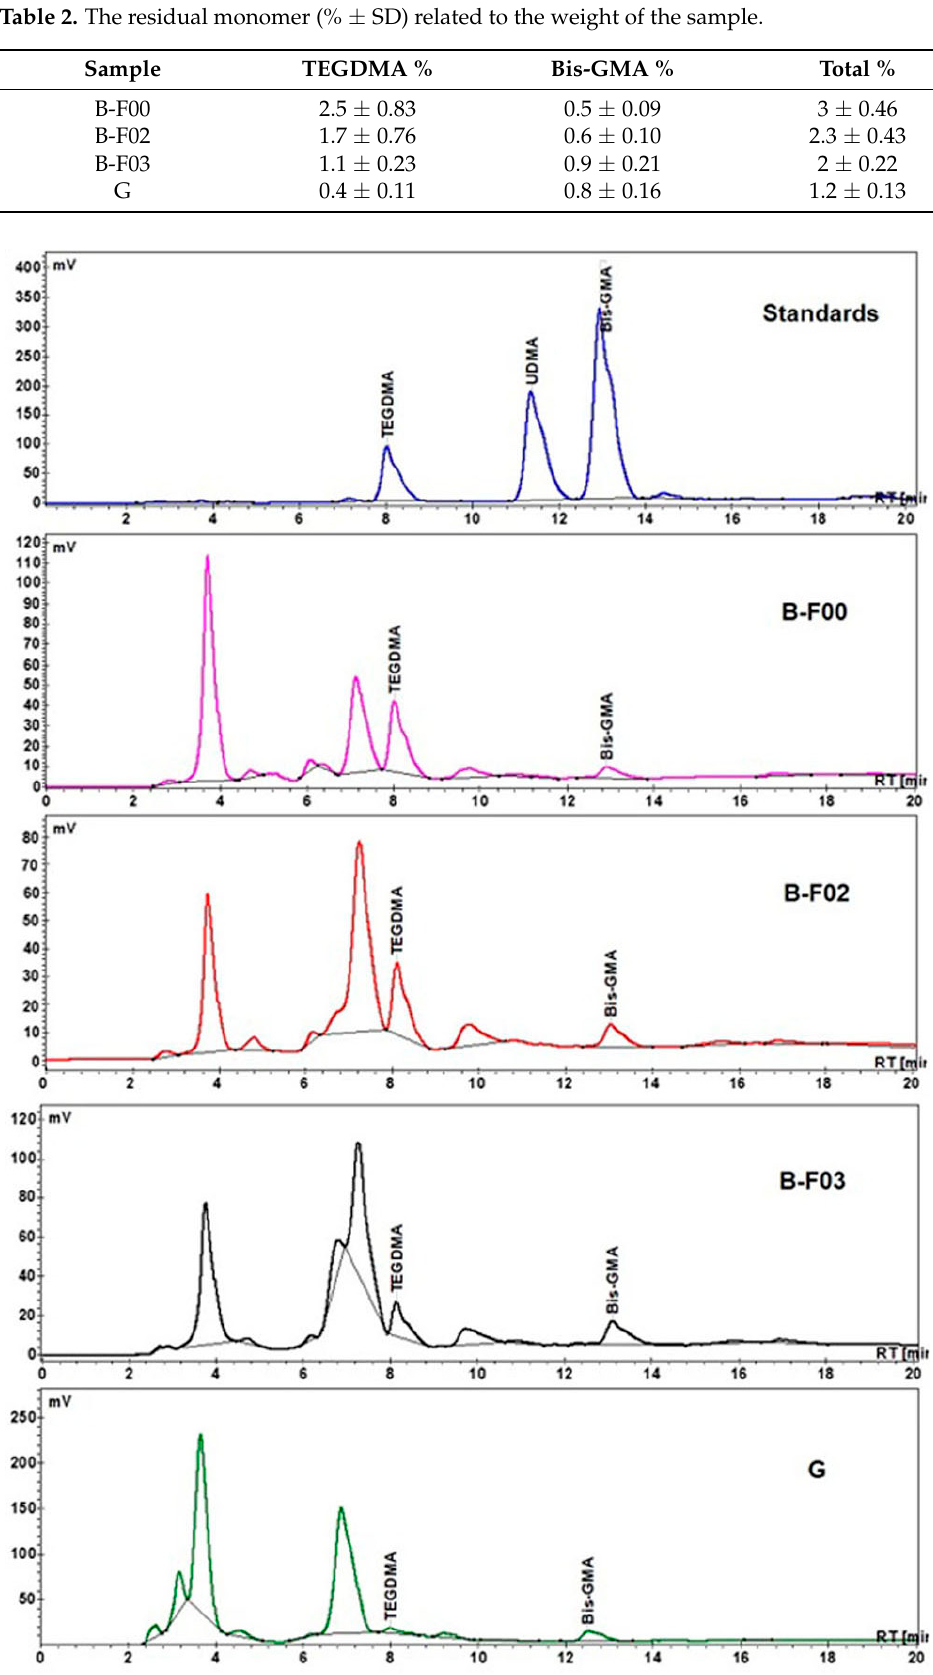
Figure 3. HPLC chromatograms of standards and investigated samples.